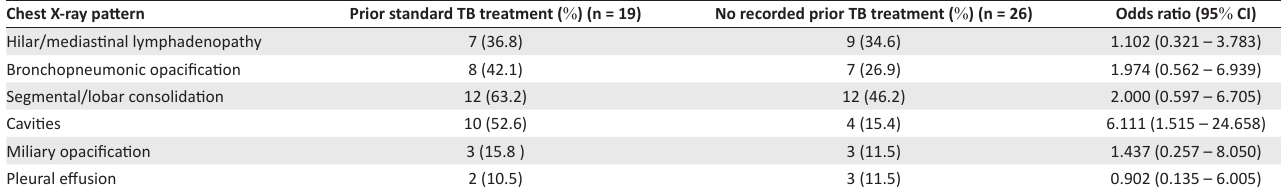
TABLE 2: Comparison of chest X-ray patterns in children with prior standard TB treatment for the current episode and children with no recorded prior standard TB treatment for the current episode. Chest X-ray pattern